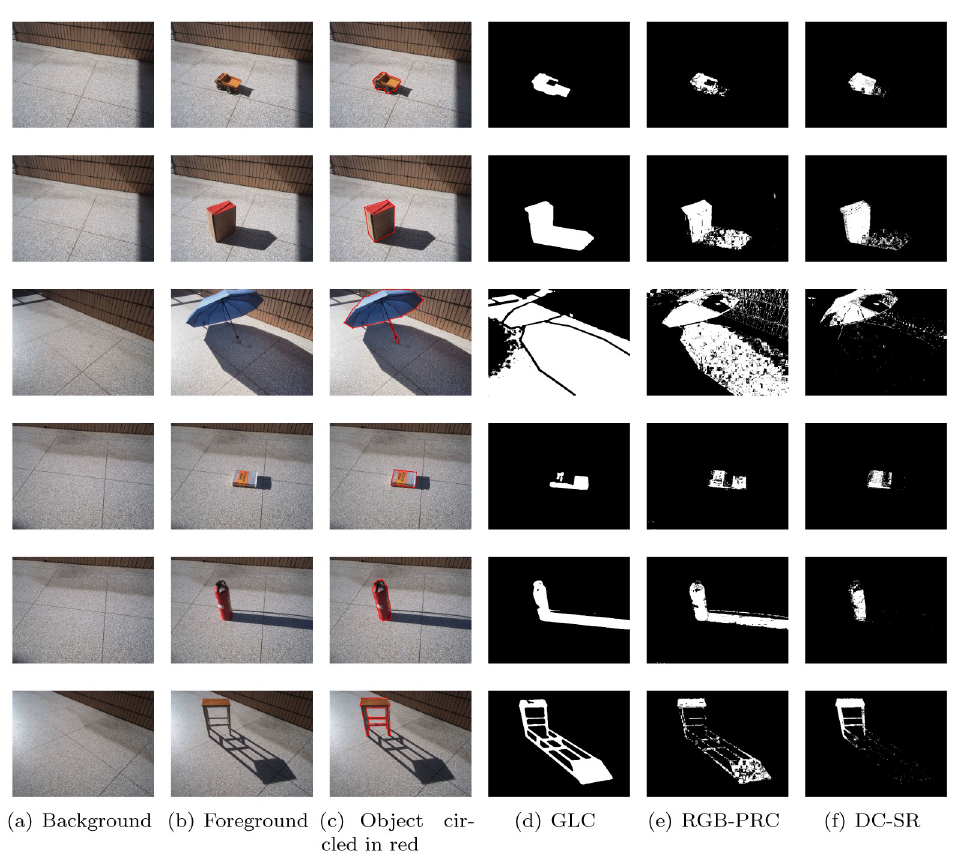
Fig 4. Comparison of shadow removal with GLC, RGB-PRC and DC-SR methods, respectively, in outdoor environments. (a) Background. (b) Foreground. (c) Object circled in red. (d) GLC. (e) RGB-PRC. (f) DC-SR.